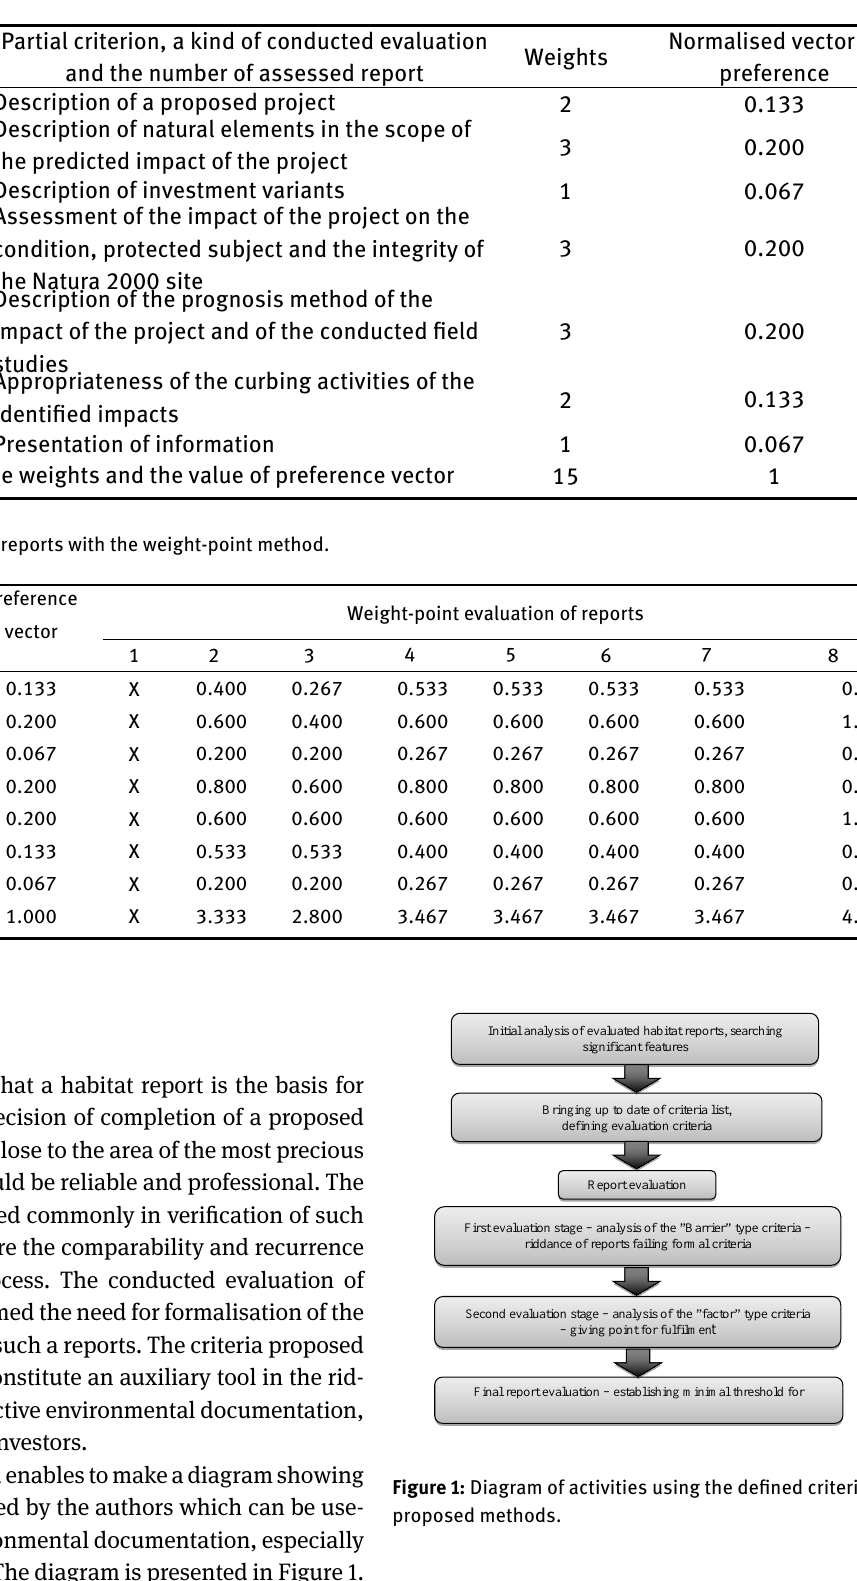
Table 4: Weights of evaluation criteria.